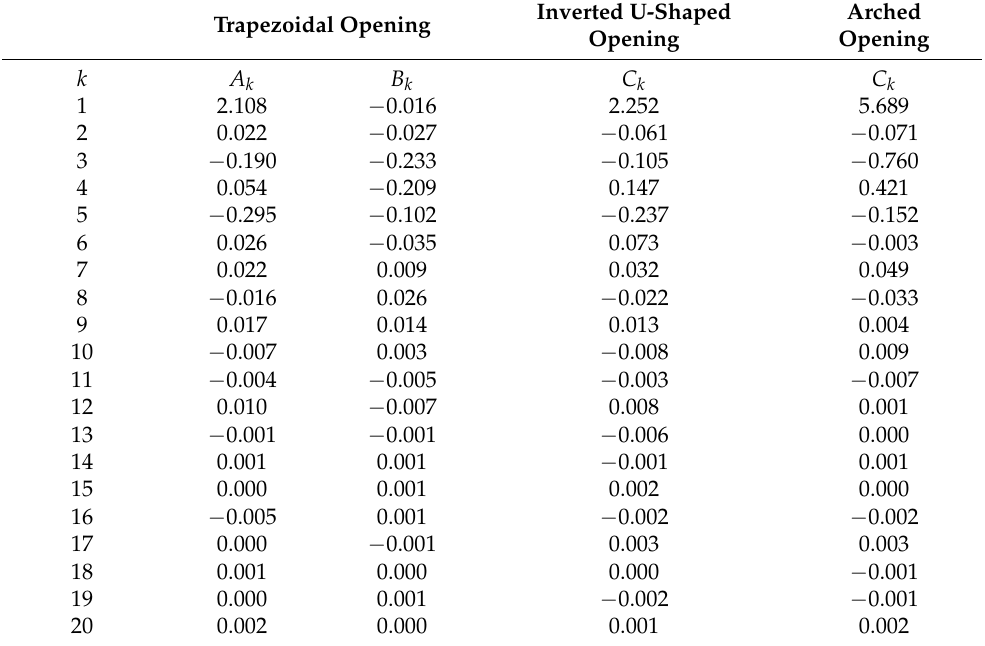
Table 1. Mapping function parameters of plates with different openings.